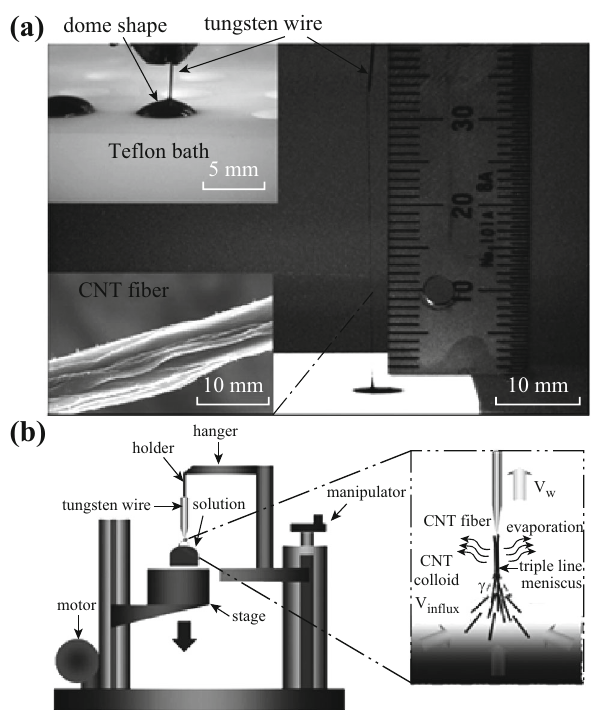
Fig. 4 a Optical photograph showing the tungsten wire immersed in a SWNT colloidal solution (upper inset; scale bar 5 mm), the SWNT fiber being formed during the withdrawal process (main panel; scale bar 10 mm). SEM image of the lower inset showing the magnified SWNT fiber in the dotted circle (scale bar 10 mm). b Schematic of the experimental setup and the formation mechanism of the SWNT fiber. Reproduced with permission from Ref. [20]. Copyright